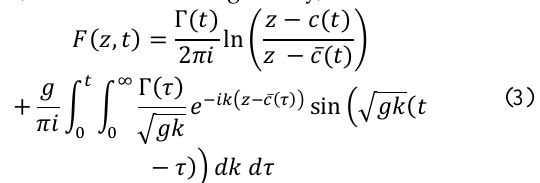
First, the radiation wave field of CycWEC